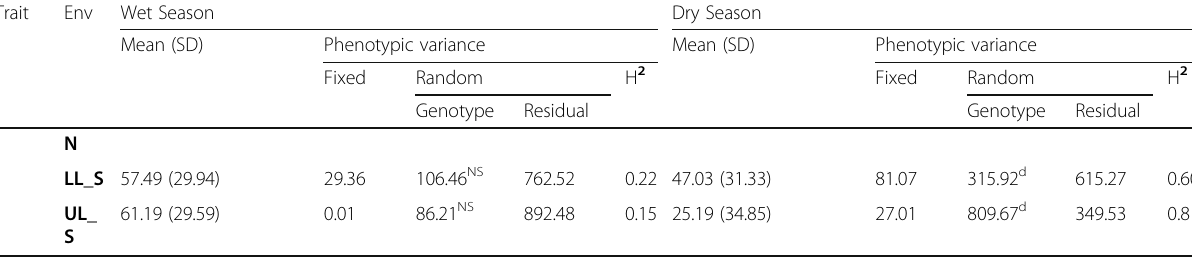
Table 1 Summary statistics and sources of variation for the ten phenotypic traits under three different environments and two seasons for the diverse set of 280 lines (Continued)